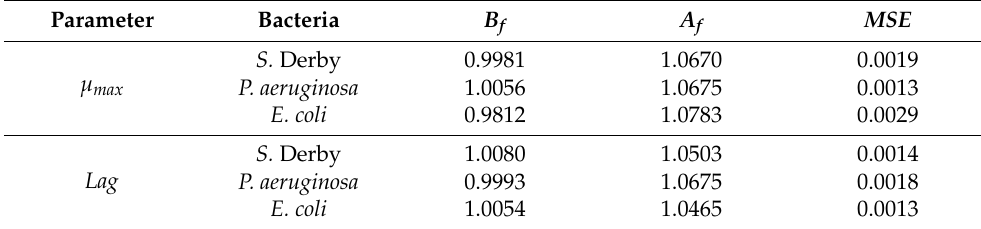
Table 3. Various statistical characteristics of the secondary growth models.